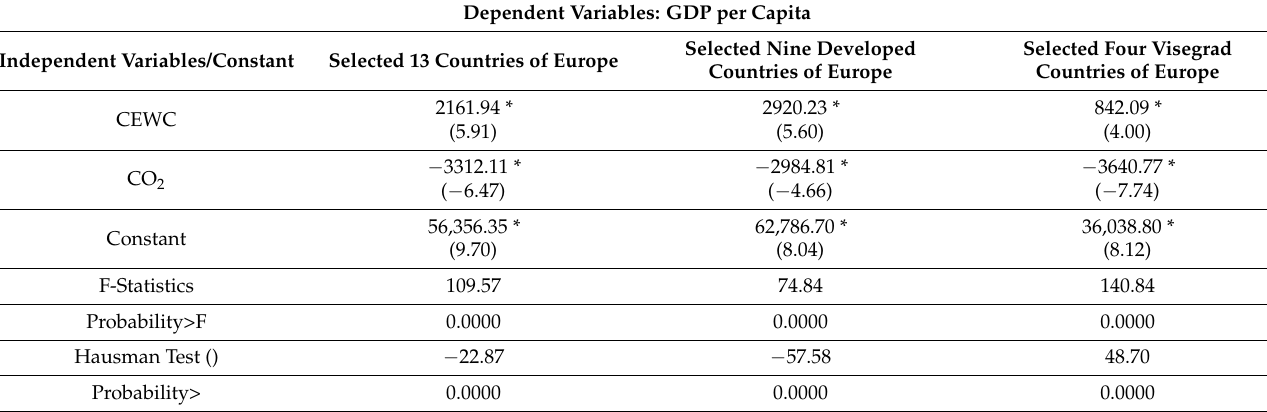
Table 5. The Results of Fixed Regression